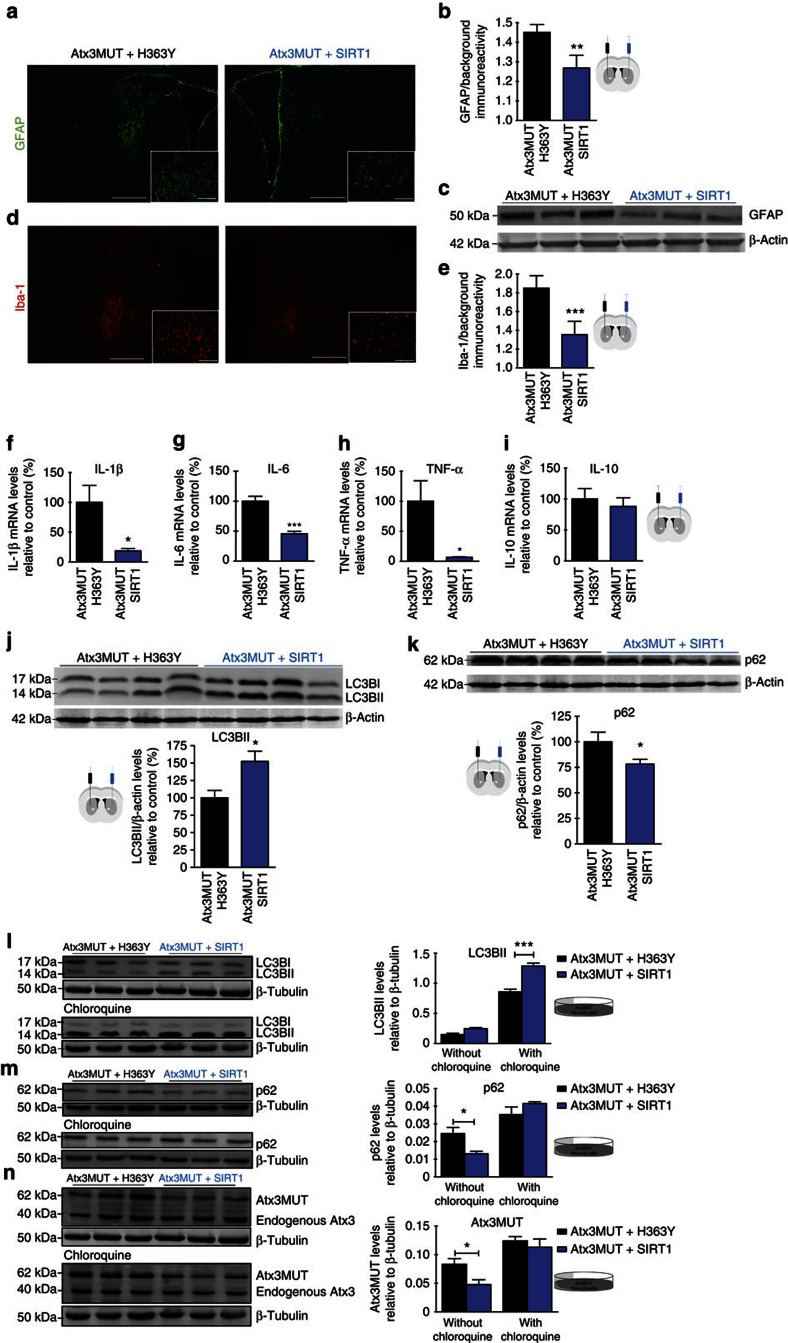
SIRT1 overexpression reduces MJD-associated neuroinflammation and activates autophagy.(a–e) Quantitative analysis of glial fibrillary acidic protein (GFAP) and ionized calcium binding adaptor molecule 1 (Iba-1) immunoreactivity at 4 weeks after the co-injection of the viral vectors in the striatal lentiviral model of MJD. (a–c) SIRT1 decreased astrocytic activation induced by mutant ataxin-3, evidenced by the decrease in GFAP immunoreactivity and by the reduction in GFAP protein levels, evaluated by western blotting in c. (d,e) SIRT1 reduced microglia recruitment triggered by mutant ataxin-3, supported by the decrease of Iba-1 immunoreactivity, in comparison with the control hemisphere. Scale bar, 500 μm in larger images and 100 μm in smaller images. (f–i) mRNA levels of inflammatory cytokines were evaluated by quantitative reverse transcriptase–PCR. (f–h) mRNA levels of pro-inflammatory IL-1β, IL-6 and TNF-α cytokines were significantly decreased in the hemisphere where SIRT1 was overexpressed. (i) mRNA levels of anti-inflammatory IL-10 cytokine were not changed with SIRT1 overexpression. (j,k) SIRT1 overexpression activates autophagic flux in the striatum of striatal lentiviral model of MJD. (j) SIRT1 overexpression induces an increase in LC3BII levels, in comparison with the overexpression of H363Y. (k) SIRT1 overexpression reduces significantly p62 levels, in comparison with the hemisphere where H363Y was overexpressed. (l–n) Neuro 2a cells were co-infected with lentivirus encoding for mutant ataxin-3 and for H363Y (control condition) or co-infected with lentivirus encoding for mutant ataxin-3 and for SIRT1. (l) SIRT1 overexpression in the presence or absence of an autophagic flux inhibitor increased LC3BII levels. (m) In the absence of chloroquine, p62 levels were increased and did not change in the presence of the lysosomal inhibitor. (n) Mutant ataxin-3 levels were reduced when SIRT1 was overexpressed in the cells, in the absence of chloroquine. In the presence of chloroquine, the changes were not observed. Data represent mean±s.e.m. *P<0.05 , **P<0.01 and ***P<0.001 compared with control. (b,e–k). Paired Student's t-test. n=4. (l–n) Two-way analysis of variance with Bonferroni's post-hoc test. n=4. See also Supplementary Figs 3–5.